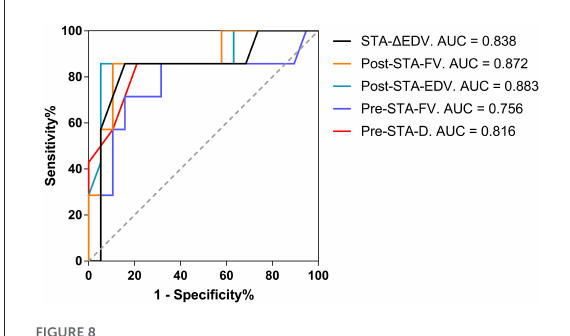
FIGURE8 The AUC for the collateral development after STA-MCA anastomosis. AUC, an area under the Receiver Operating Characteristic curve; STA, superficial temporal artery; MCA, middle cerebral artery; 1 , the difference between postoperative and preoperative parameters; EDV, end-diastolic velocity; Post, postoperative; FV, flow volume; Pre, preoperative; D, inner diameter.